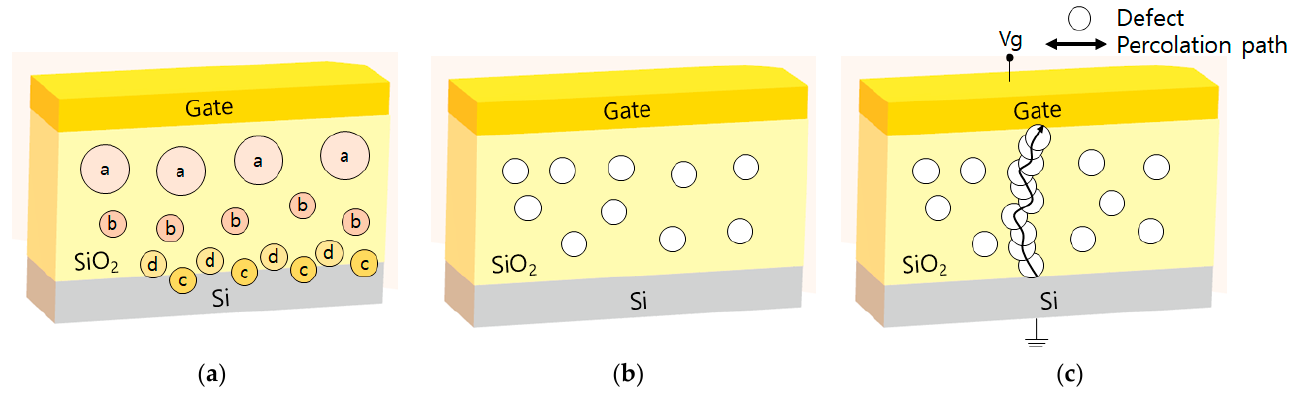
Figure 2. ( a ) Properties and positions of oxide charges in MOSFET structure. Percolation path ( b ) before and ( c ) after, applying the external voltage.